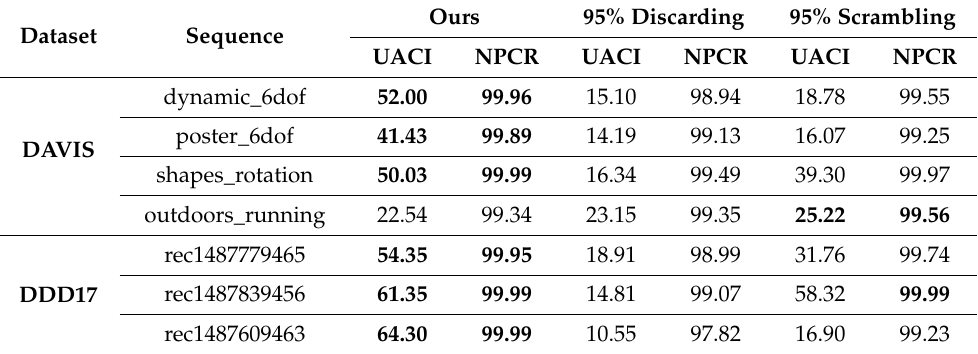
Table 2. The UACI and NPCR results of the comparison between the original reconstructed images and the reconstructed images after using different encryption